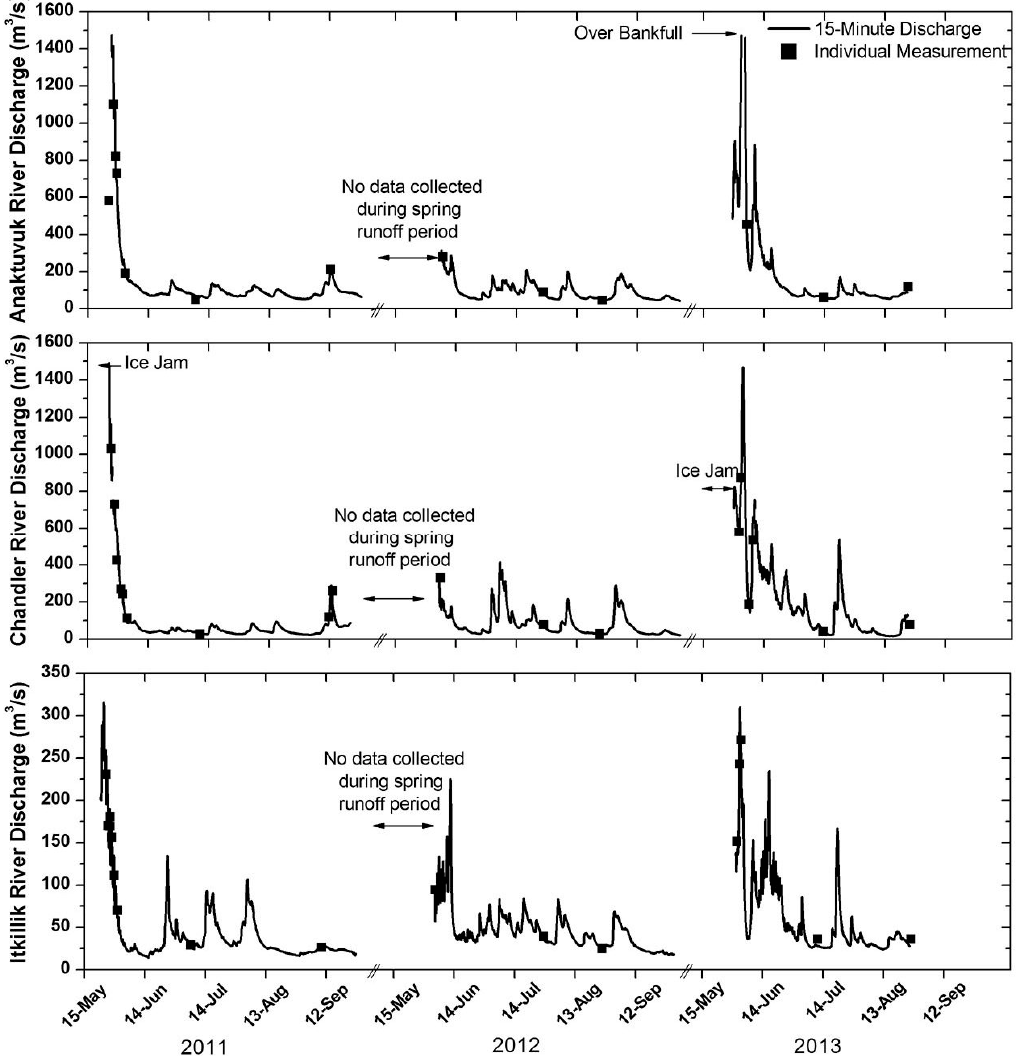
Figure 5. River hydrographs. Modified from [29].